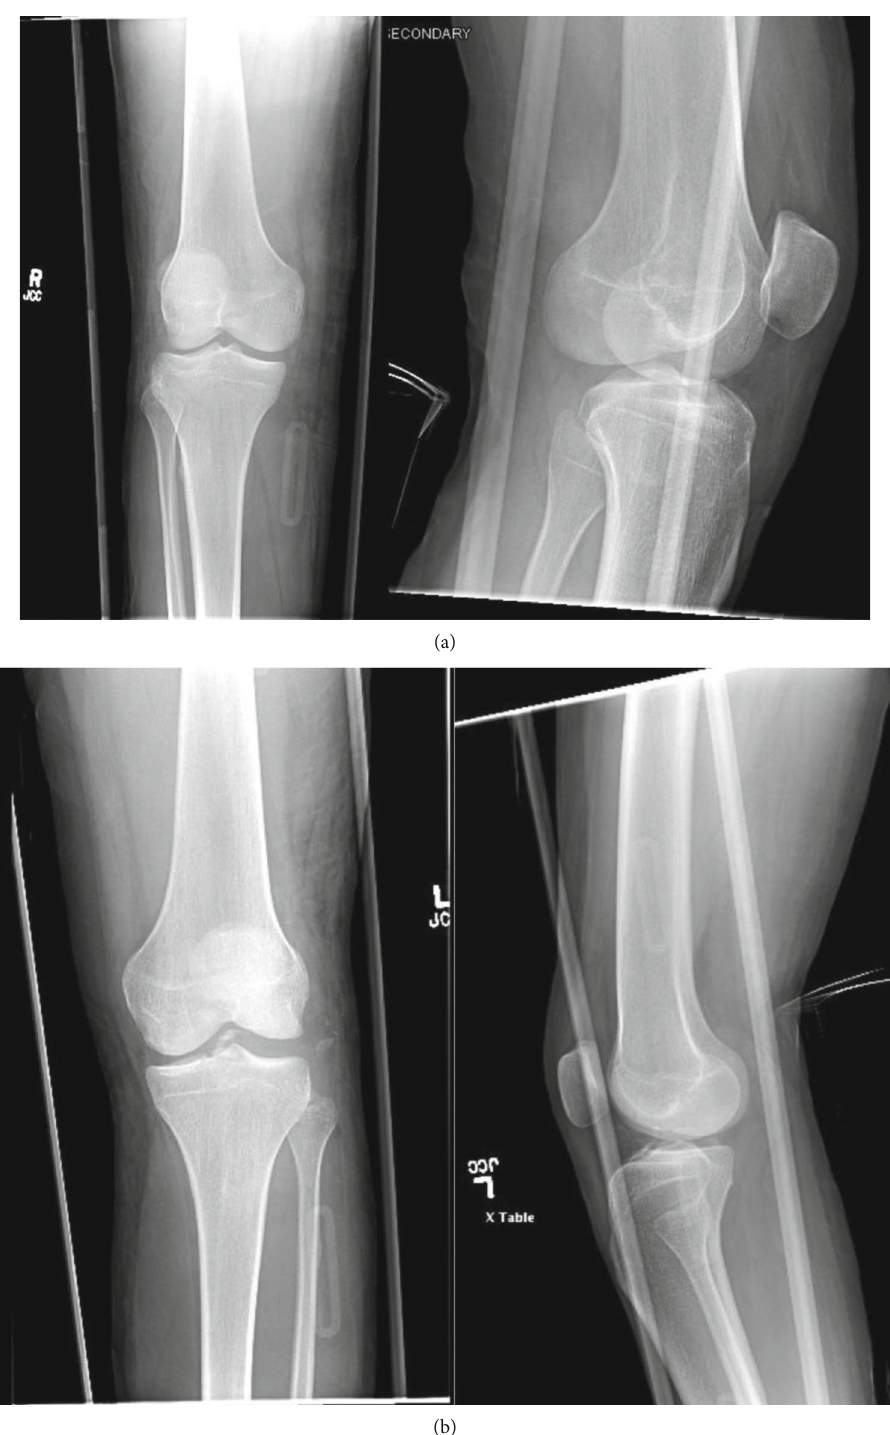
Figure 1: (a) Postreduction X-rays of the right knee. (b) Postreduction X-rays of the left